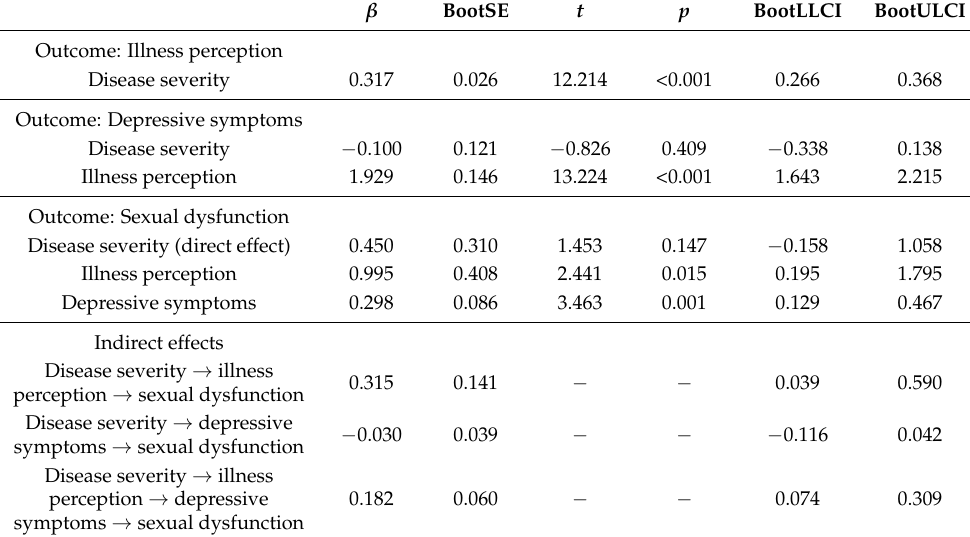
Table 2. Serial mediation analysis